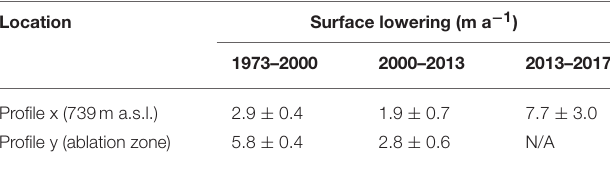
TABLE 1 | Surface lowering rates for Benito Glacier between 1973 and 2017. Profiles x and y are located in Figure 1 .